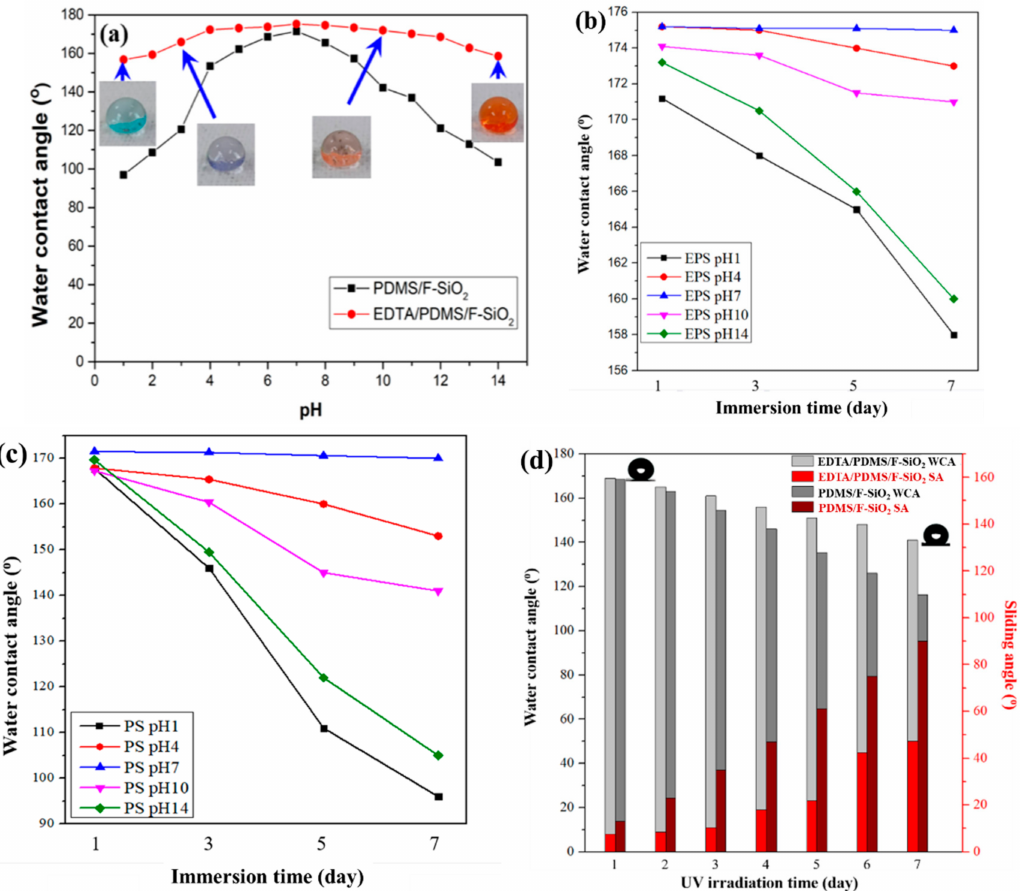
Figure 5. ( a ) Variations in WCAs of as-prepared superhydrophobic EPS@textile and PS@textile with pH. The down inset is the optical image of a water droplet with different pH values; the effect of pH value on WCAs of ( b ) EPS@textile and ( c ) PS@textile with the immersion time; ( d ) variations in WCAs and SAs of the EPS@textile with UV irradiation time. Insets are photographs of a water droplet on the EPS@textile after 1 and 7 days of UV